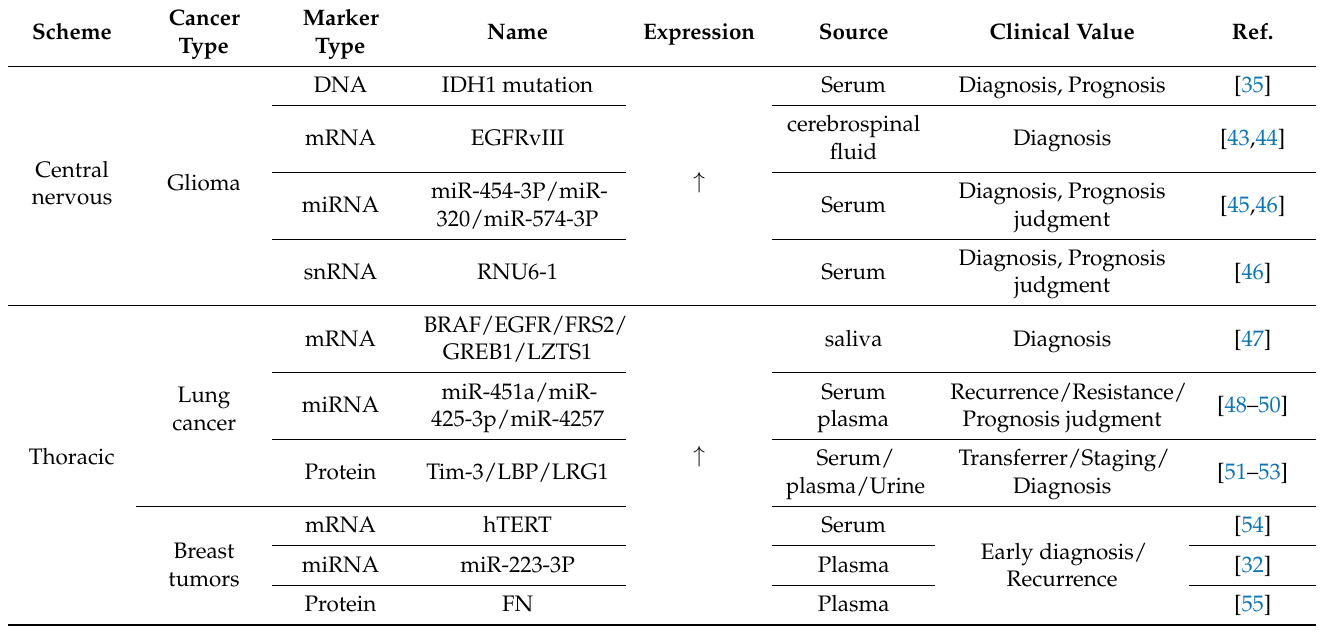
Table 1. Clinical significance of molecular markers of tumor-derived exosomes.